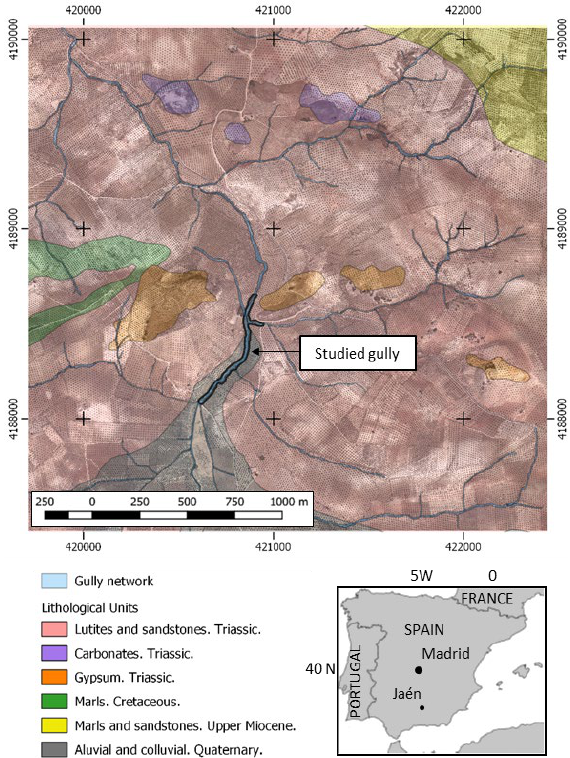
Figure 1. Geographical location and geological setting of the study area. Geological units are overlayed on the orthoimage. (Modified from Fernández et al., 2020 a-b).